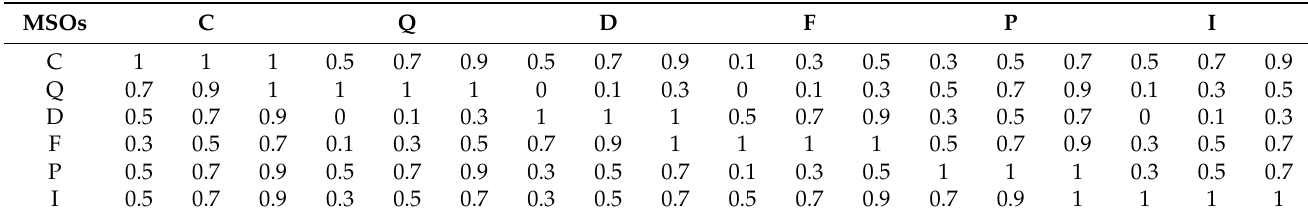
Table 4. Fuzzy direct-influence matrix.